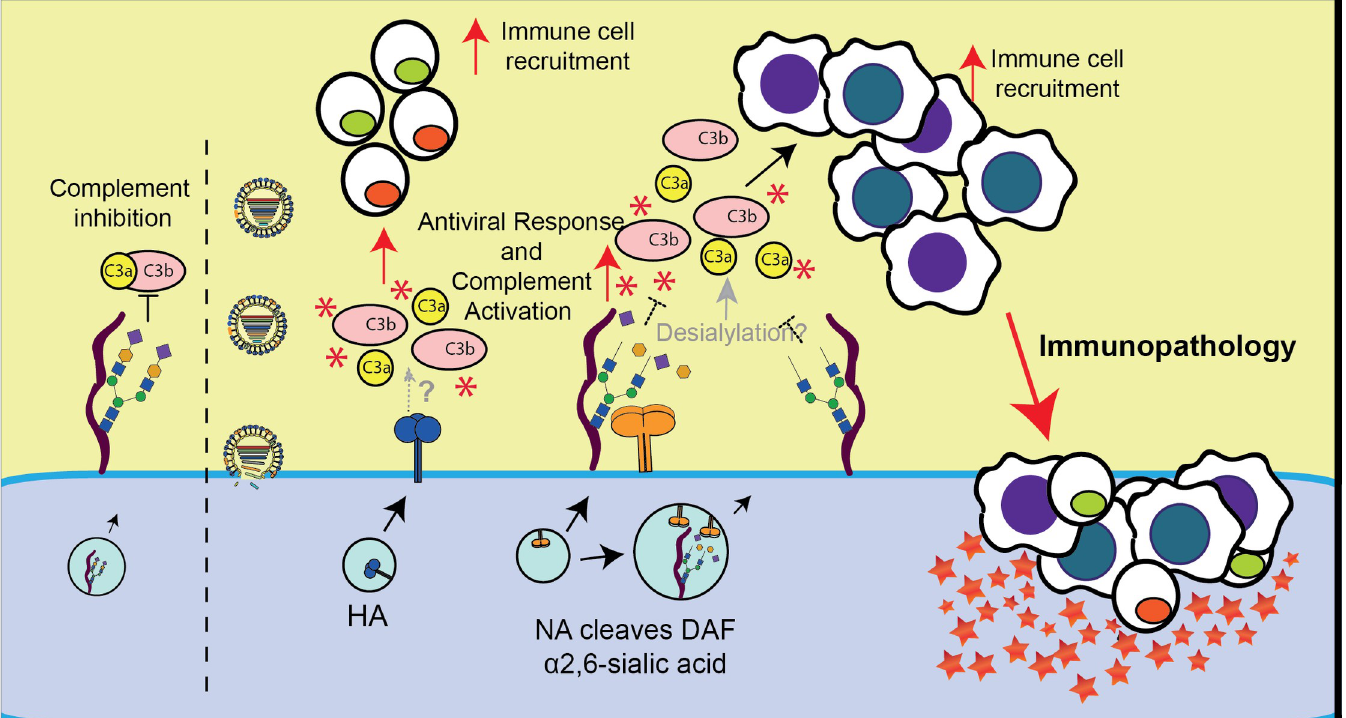
Fig 11. Proposed model for DAF-mediated immunopathology. At steady state, DAF accelerates the decay of C3 convertases, inhibiting the formation of C3a and C3b and subsequent complement activation. Upon IAV infection, the cell will produce viral proteins, and in particular HA (in blue) and NA (in orange). NA is a potent sialidase that will remove the sialic acid content of DAF both in the cytoplasm and at the surface. This processing of DAF by NA may lead to DAF loss/alteration of function. Desialylation of DAF would then impair the inhibition of C3 convertases leading to overactivation of the complement pathway. In parallel, the presence of HA at the cell surface may exacerbate complement activation that could then not be controlled by a desialylated DAF. The activation of complement pathway via HA, combined with the lack of inhibition due to NA sialidase activity would induce complement overactivation, leading to C3a release. Moreover, the presence of HA at the cell membrane and recognition of desialylated surface proteins by PRR would induce an exacerbated immune response (red asterisks). Consequently, an excess of innate immune cell recruitment and inflammation would promote tissue damage and ultimately immunopathology, worsening disease outcome. (Black arrows indicate confirmed events whereas grey arrows indicate speculative events needing further validation. Red arrows indicate events that will worsen disease outcome).